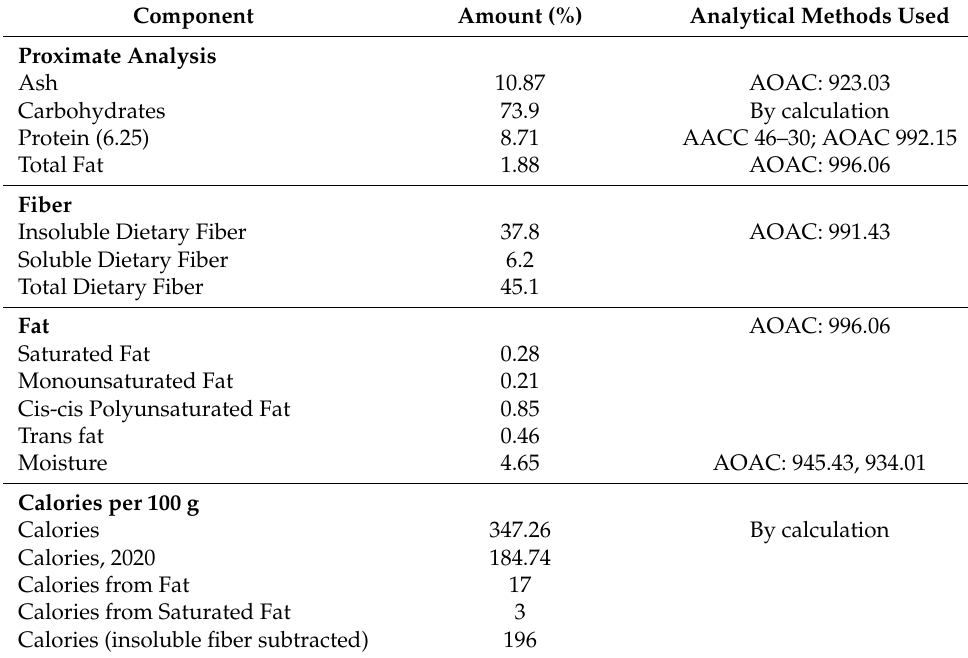
Table 1. Nutrient analysis of leaves and stems of kale.